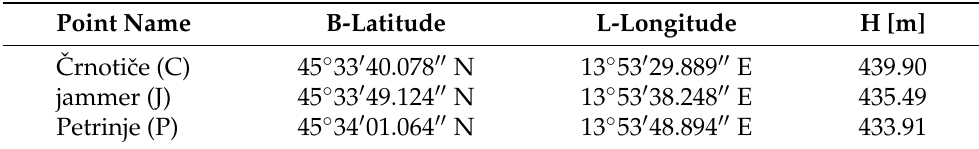
Figure 4. The principle of localising of the moving vehicle with an array of GNSS receivers, while the jammer is set statically by the road (own study). Table 1. Locations in the ETRS89 coordinate system of the most distinct points of driving, towards Petrinje (P) and ˇCrnotiˇce (C). The height of the jammer (J) is related to the point on the ground, but the jammer was set at different points above the ground. Heights (H) were acquired from the ellipsoidal heights by using the SLOVRP2016/Koper geoid